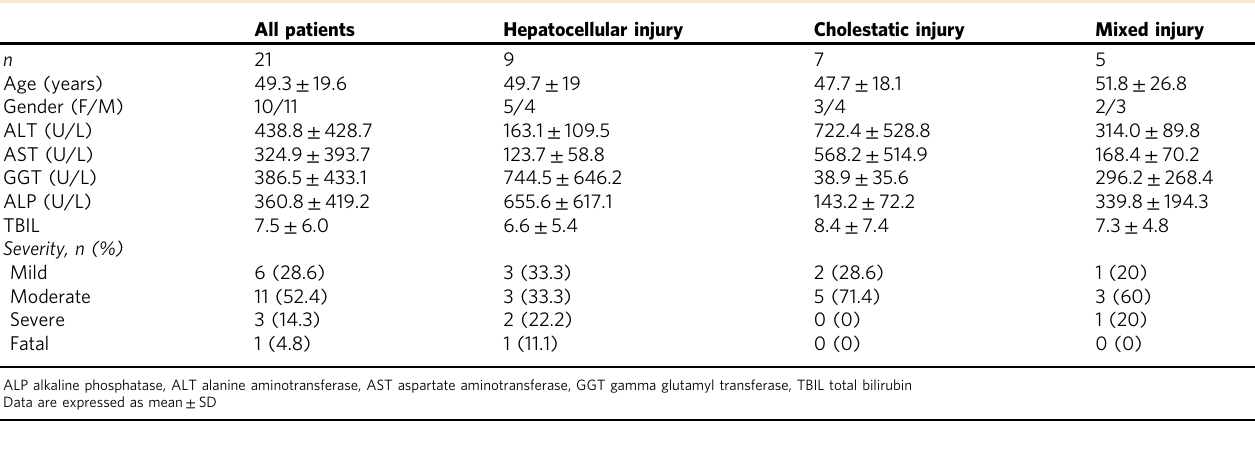
Table 1 Characteristics of DILI patients